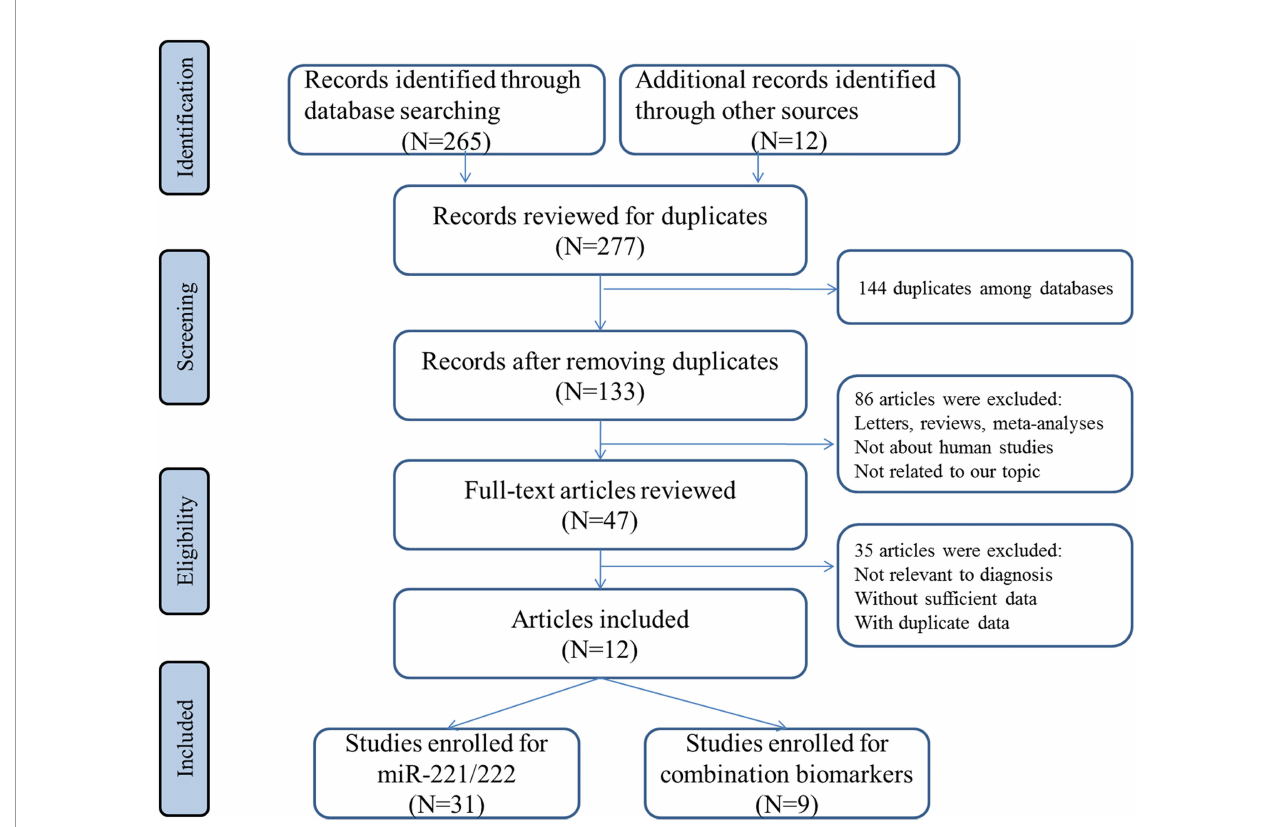
FIGURE 1 | Flowchart of the study